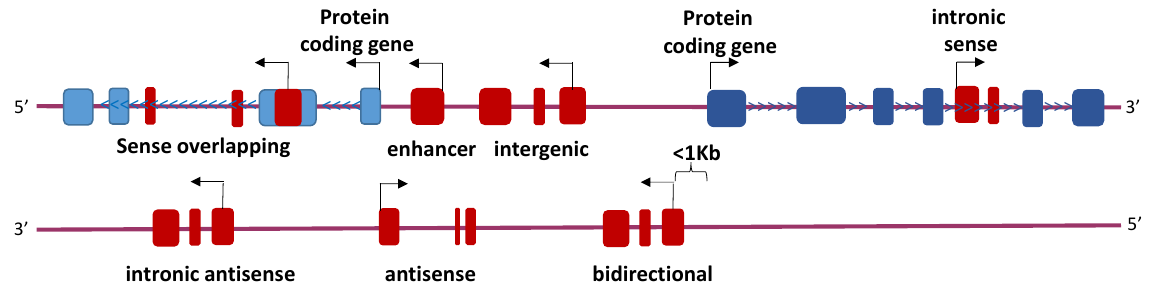
Figure 2. lncRNA classification attending to their localization. The enhancer, intronic, and intergenic lncRNAs contain their own promoters that are distinct from protein coding gene. Bidirectional lncRNAs share promoter with a protein coding gene and are transcribed from the opposite strand of the gene. Antisense (AS) lncRNAs have been involved in the transcriptional interference of the neighboring protein coding genes.